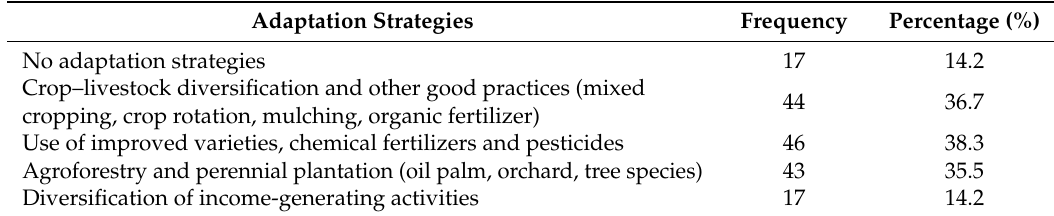
Table 2. Adaptation strategies used by